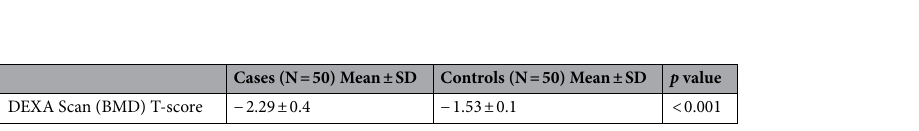
Table 4. Dual energy X ray absorptiometry among studied groups. DEXA dual energy x-ray absorptiomet ry.